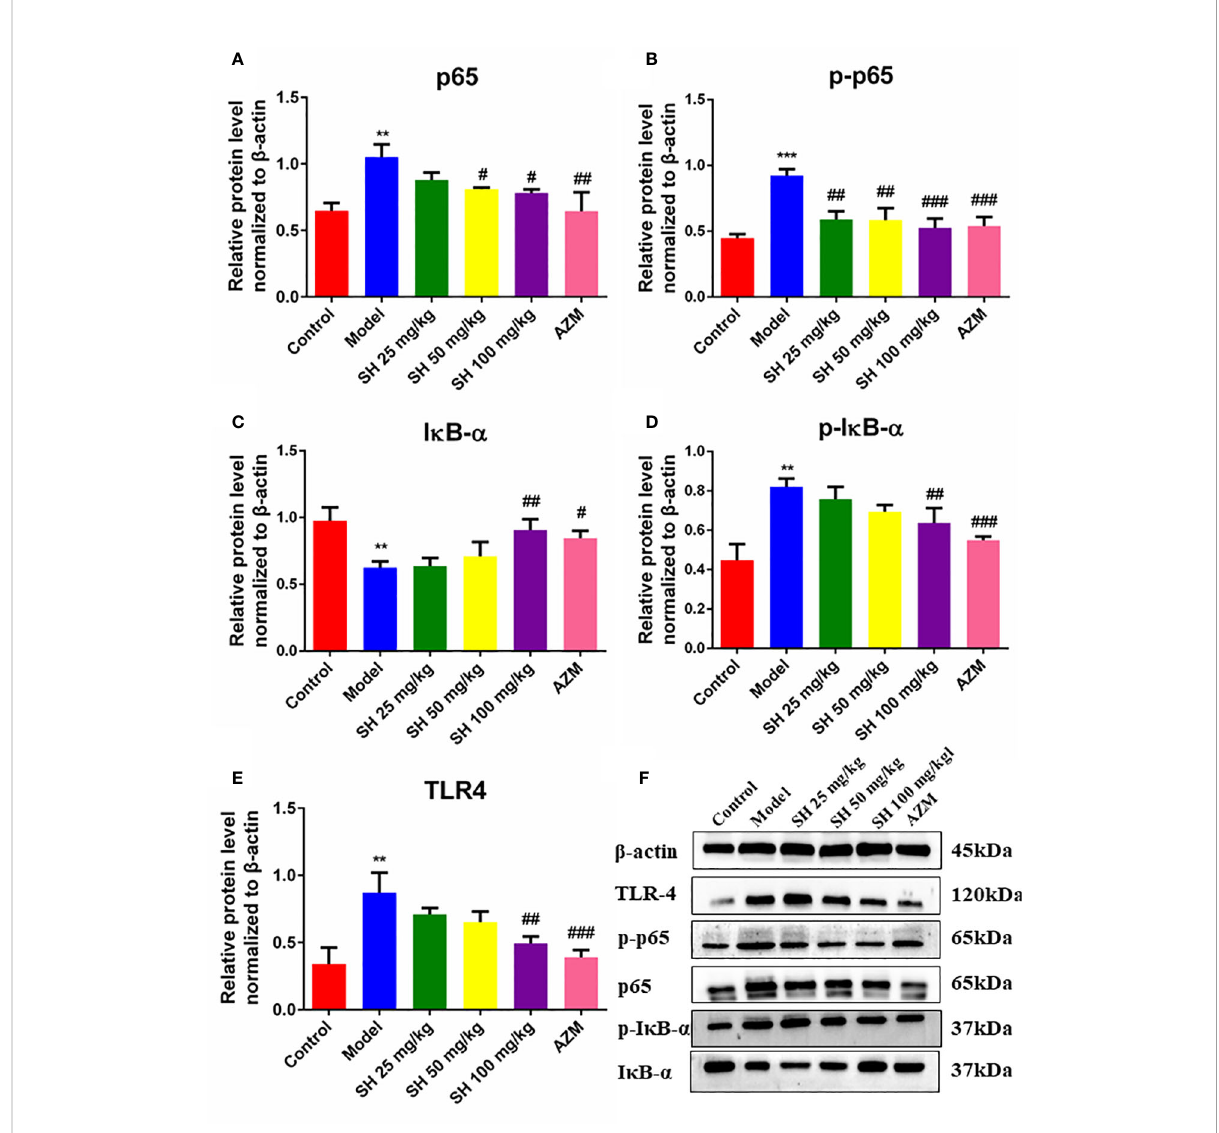
FIGURE 4 The expression of in fl ammatory proteins in pneumonia mice after SH treatment. (A) p65. (B) p-p65. (C) I k B- a . (D) p-I k B- a . (E) TLR4. (F) The expression of proteins. Staining intensity was assessed with Image J. Data are represented as mean ± SD (n=3). **P<0.01 and ***P<0.001 mean signi fi cance of model group compared with control group. # P<0.05, ## P<0.01 and ### P<0.001 mean signi fi cance of drug treatments compared with the model